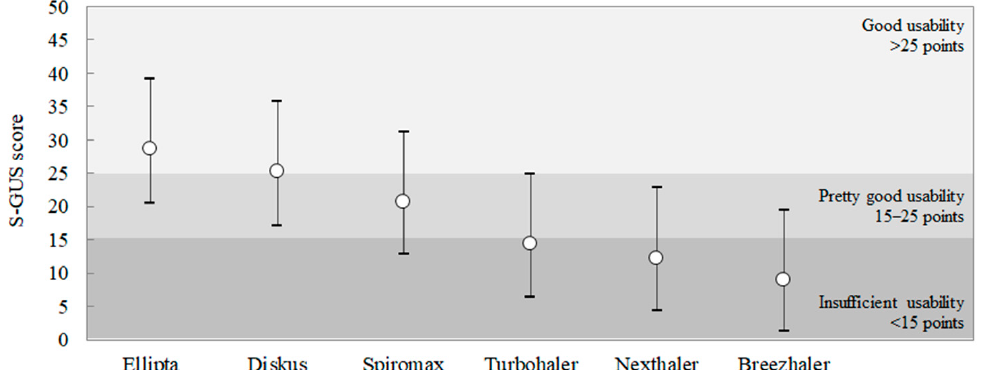
Figure 2. Cumulative ranking probability plots from the six DPIs.